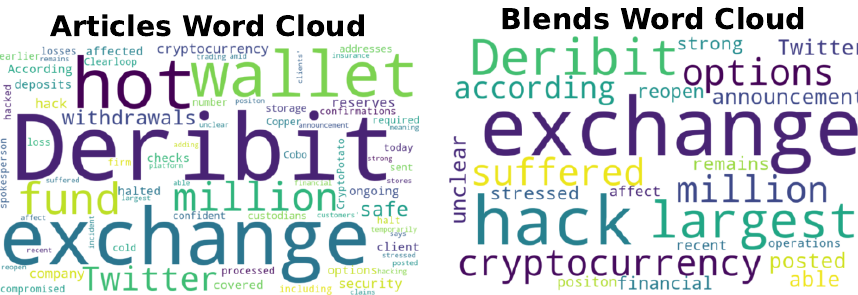
Figure 7. Comparison between the word clouds obtained by the original articles ( left ) and the resulting summary contained in the corresponding blend ( right